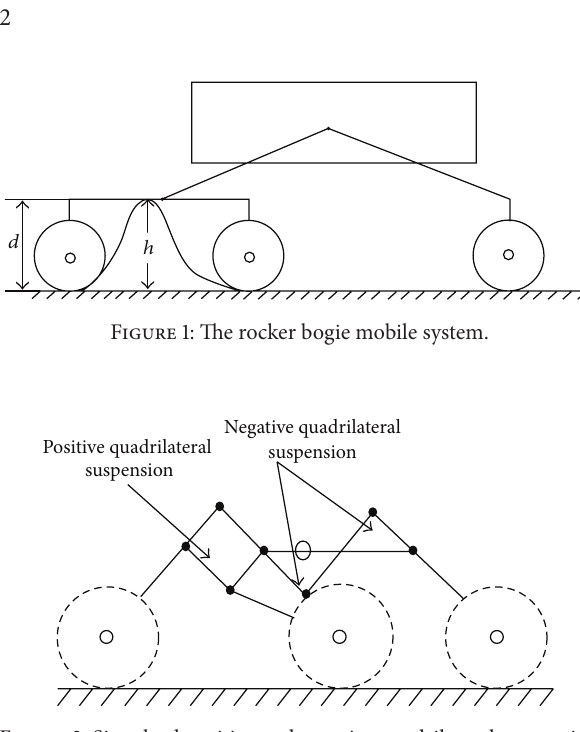
Figure 2: Six-wheel positive and negative quadrilateral suspension system.